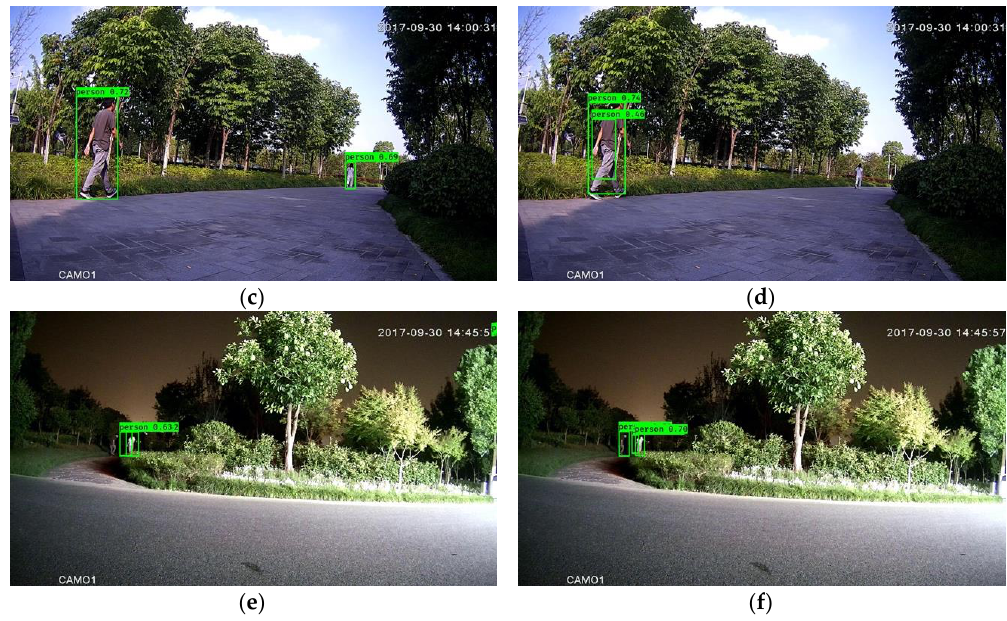
Figure 7. Outcomes of the framework with 96*96 input size without downsampling ( a,c,e ) and with downsampling ( b,d,f ). The left column and right column correspond to the same images.